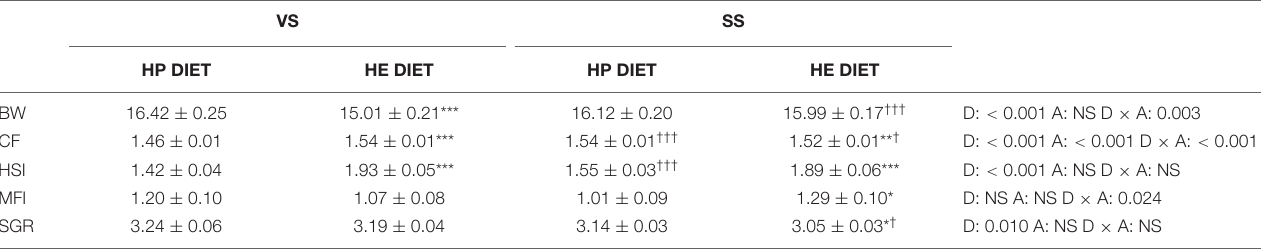
Data are presented as the mean ± SEM. Body weight (BW) and Condition factor: n = 154 for VS and n = 315 for SS conditions for each diet group (all fish). Hepatosomatic index (HSI), mesenteric fat index (MFI), and specific growth rate (SGR): n = 40 for VS and n = 120 for SS conditions for each diet group (PIT-tagged fish). The p-values of the two-way ANOVA analysis are displayed in the right column. D, diet; A, Activity; D × A, Interaction; n.s., p-value > 0.05. Pairwise comparisons were assessed by unpaired Student’s t-test. *p < 0.05, **p < 0.01, and ***p < 0.001 between diet groups (HP and HE). † p < 0.05 and ††† p < 0.001 between swimming activity groups (VS and